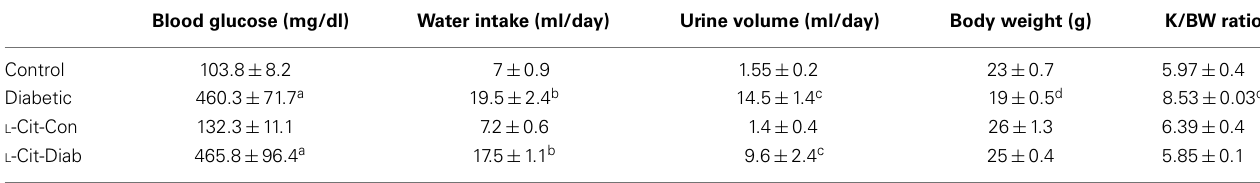
K/BW, kidney/body weight ratio; control, untreated control mice; diabetic, untreated diabetic mice; L -cit-Con, L -cit-treated control mice; L -cit-Diab, L -cit-treated diabetic mice.Values are expressed as mean ± SEM. a p < 0.001 vs. control groups; b p < 0.01 vs. control groups; c p < 0.05 vs. control groups; d p < 0.01 vs. all